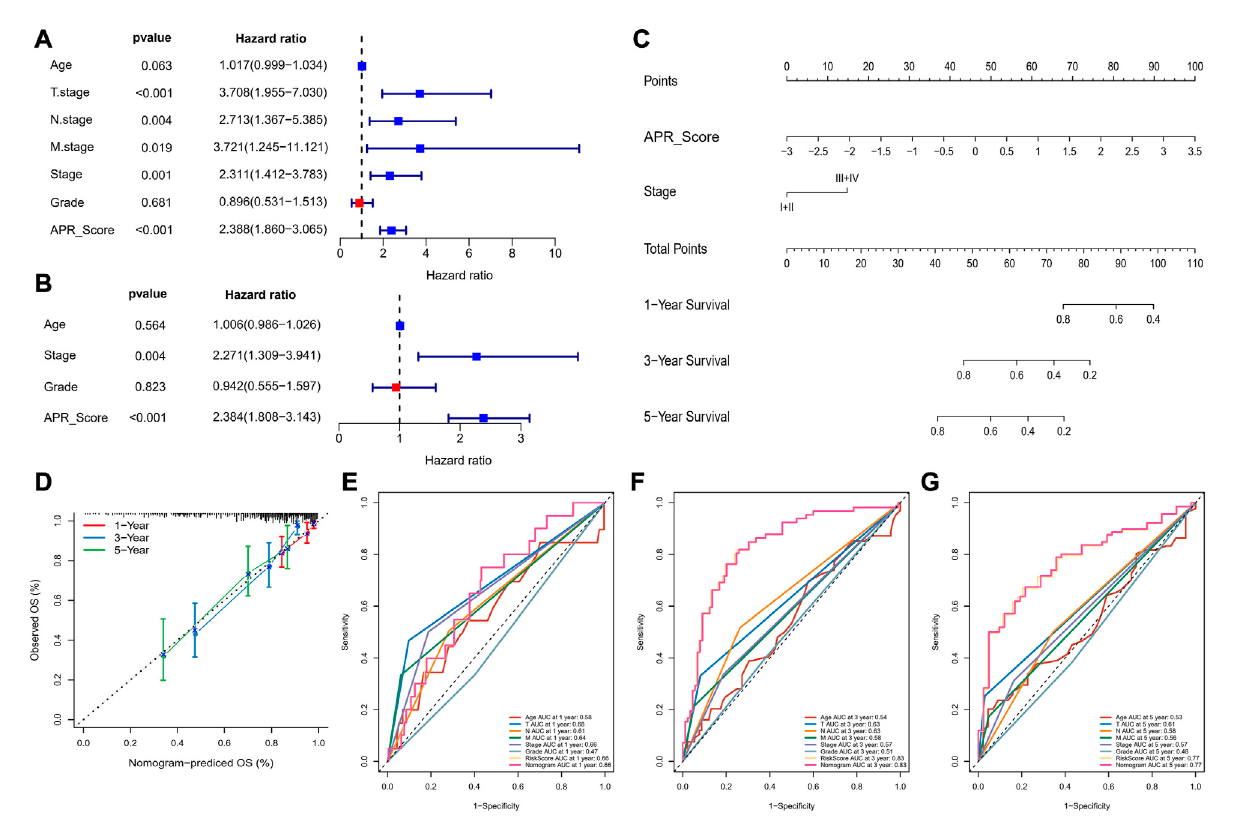
FIGURE 8 Nomogram for predicting survival rate of CC (A, B) Forest plots for univariate and multivariate COX models for APR_Score (C) Nomogram of APR_ Score and Stage (D) Calibration curves for 1-year, 3-years and 5-years survival (E – G) The ROC curves of a variety of clinical features for overall OS at 1- year, 3-year and